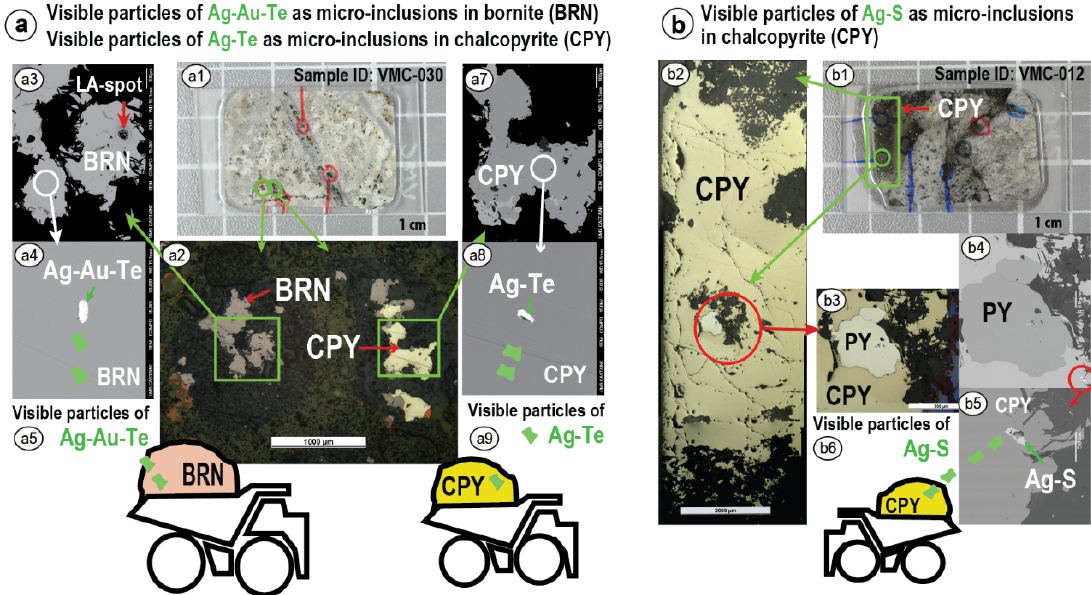
Figure 3. ( a ) Microphotograph under reflected light (a2) and BSE images (a3,a4,a7,a8) deciphering the occurrence of visible particles of Ag-Au-Te and Ag-Te, found as micron-sized inclusions in bornite and chalcopyrite, respectively. The expected final destination of these particles is also shown (a5,a9). ( b ) Microphotographs under reflected light (b2,b3) and BSE images (b4,b5) showing the occurrence of Ag-S visible particles, found as micron-sized inclusions in chalcopyrite. The estimated final destination for these metallic particles is also the flotation concentrates (b6). CPY: chalcopyrite, BRN: bornite, and PY: pyrite.